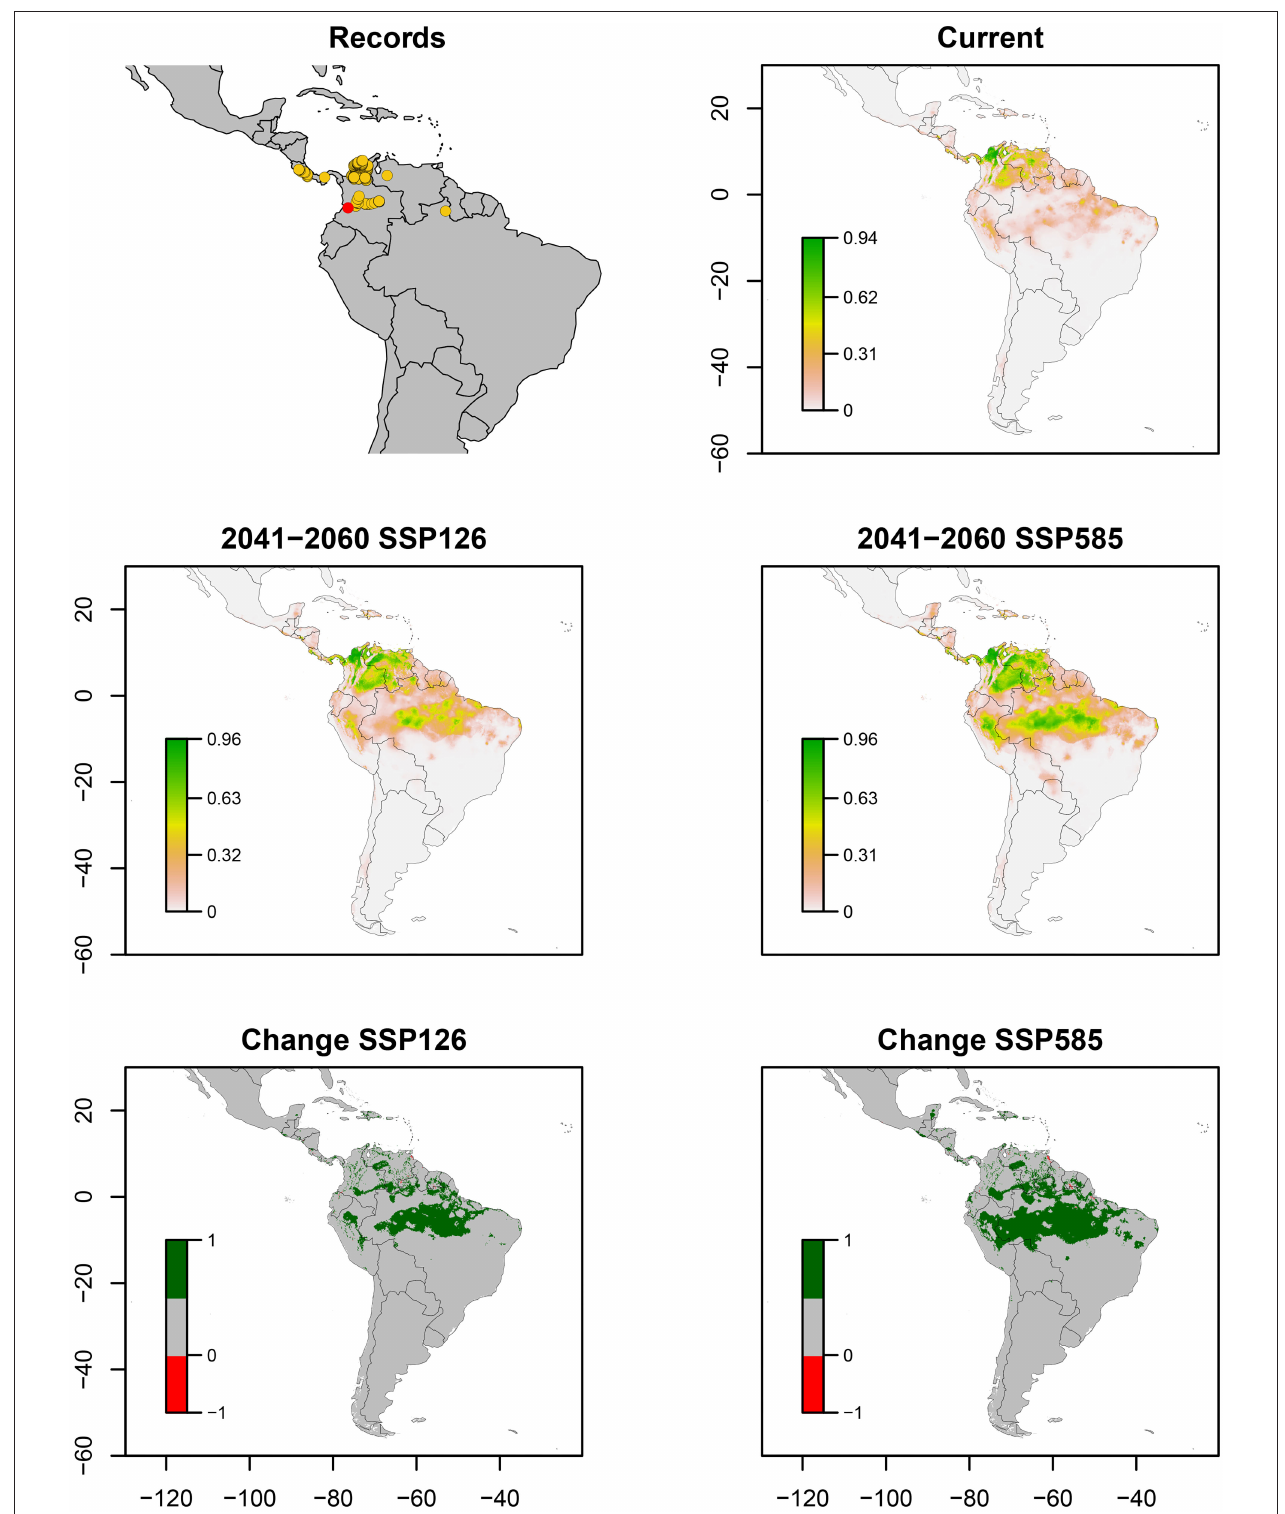
FIGURE 2 | Ecological niche models of Aeneolamia reducta. Distribution records (red point indicates the most recent report in a new niche), current potential distribution, future potential distribution (2041–2060) under SSP126 and SSP585 scenarios, and comparison between current and future scenarios (change SSP126 and SSP585). The scale shows the habitat suitability being 1 = higher suitability. Scale in change maps − 1 = possible extinction and 1 = possible invasion.